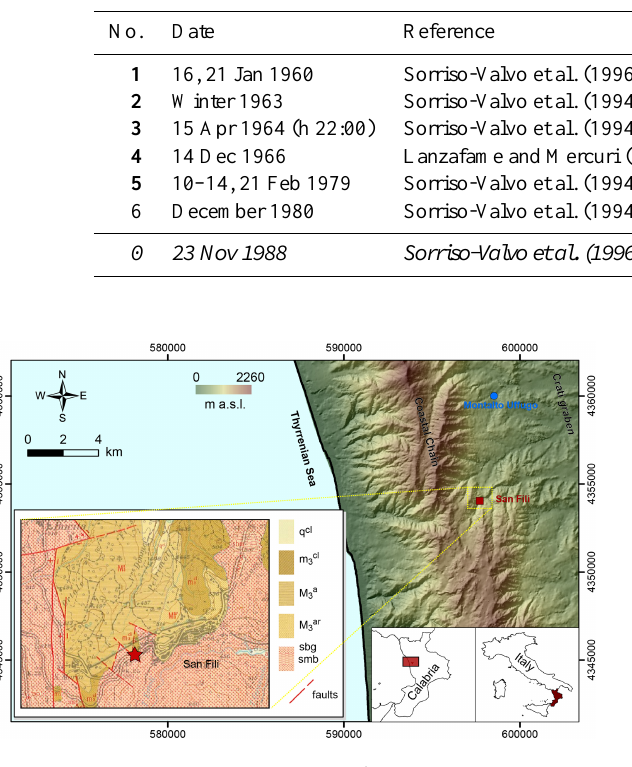
Figure 8. Location of the study area (red square: San Fili vil- lage; blue circle: Montalto Uffugo rain gauge). On bottom left, an extract from the geological map of Calabria (CASMEZ,